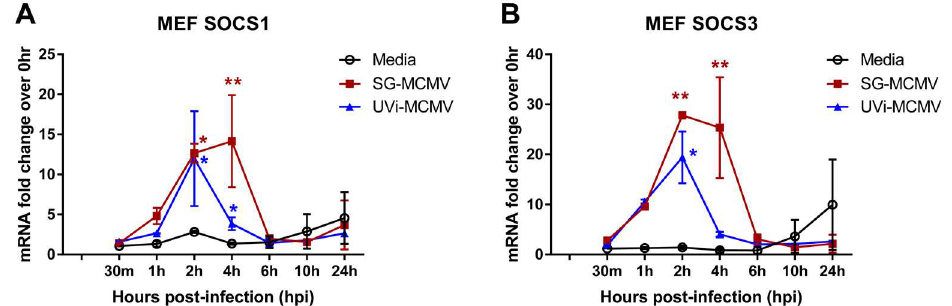
Fig 5. MCMV infection stimulates mRNA expression of SOCS1 and SOCS3 mRNA in MEFs. MEFs treated with media (control), infected with SG-MCMV (MOI = 3 PFU/cell), or treated with an equal volume of UVi-MCMV were assessedat indicatedtime points by real-time RT-PCR assay using the comparative 2 - ΔΔ Ct method for SOCS1 (A) or SOCS3 (B) mRNA transcripts, with samples comparedback to the media group at 0 hpi. Means ± SD of at least duplicateexperimental repeats are shown. * p < 0.05and ** p < 0.01,compared with media controls at the same time points.